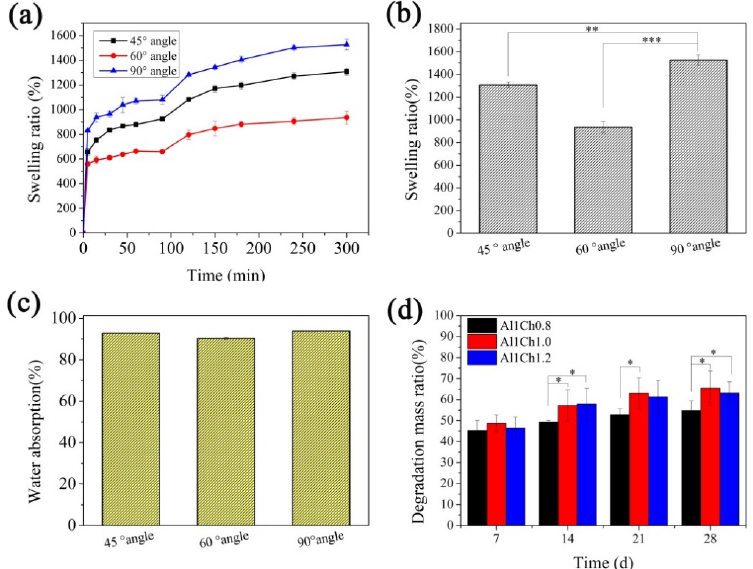
Figure 7. Physiochemical properties of 3D printed AlCh PIC hydrogels. ( a ) swelling process; ( b ) swelling ratio; ( c ) water absorption; ( d ) degradation mass ratio of hydrogels.